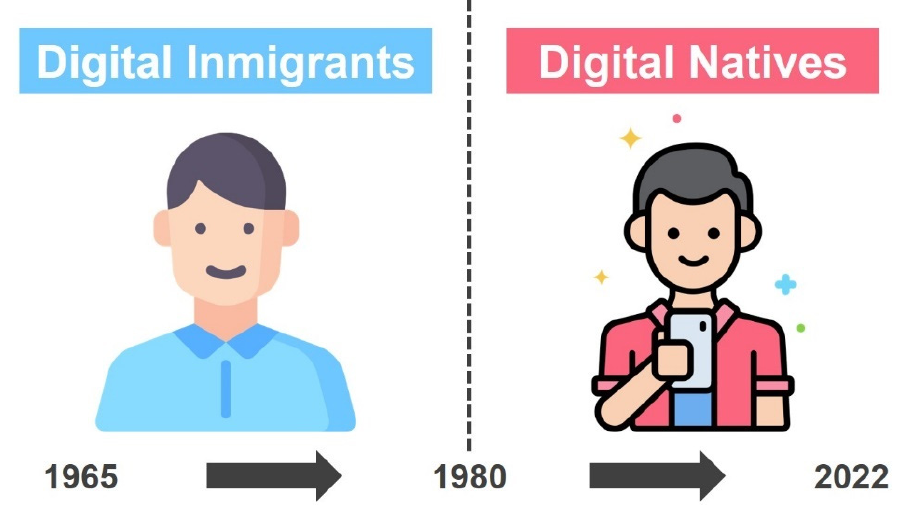
Figure 2. Digital Figure 2. Digital generations.